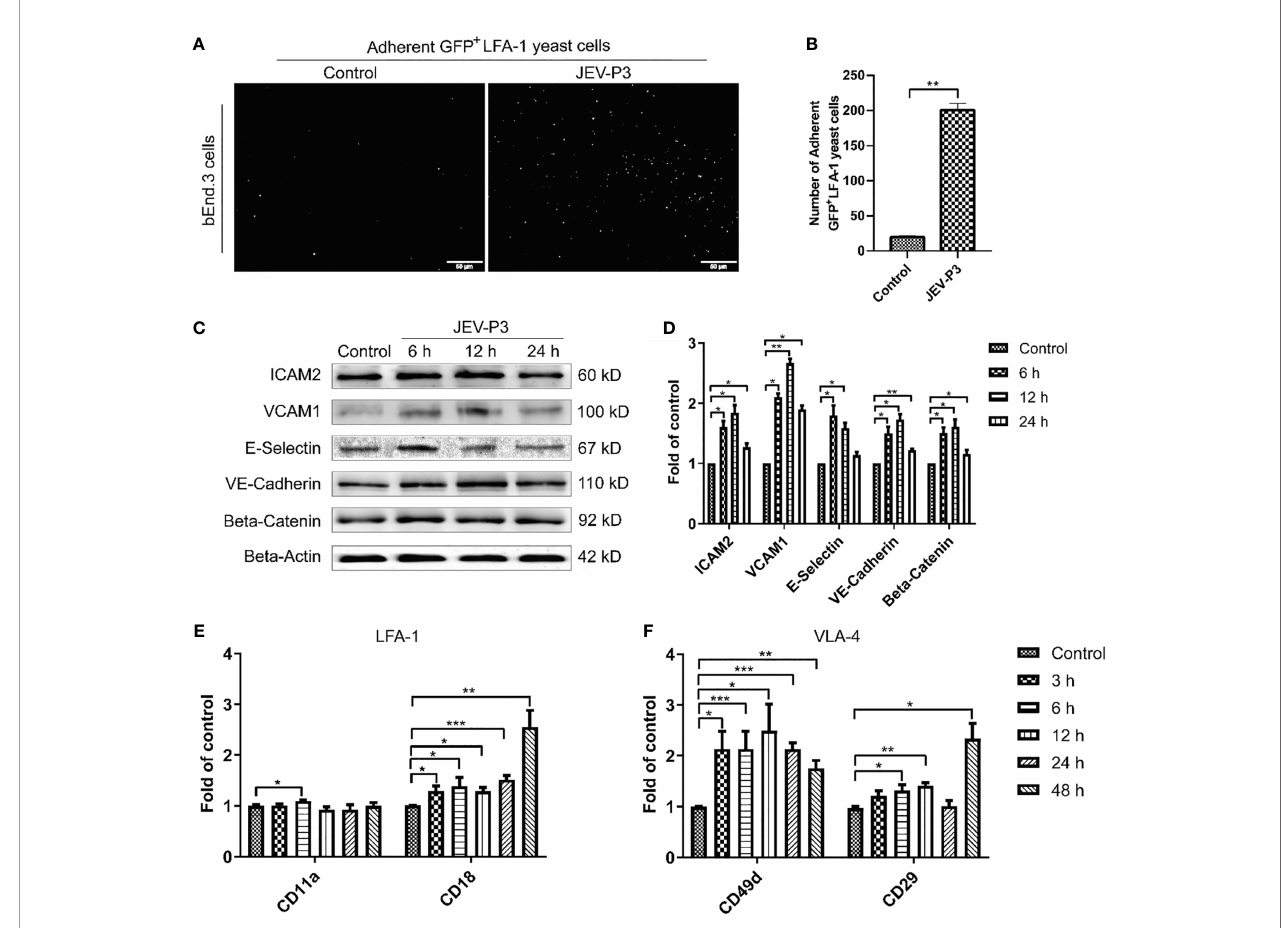
FIGURE 2 | JEV infection upregulated adhesion molecules expression in bEnd.3 cells, and rHMGB1 increased the expression of integrin ligands in splenocytes. (A) ICAM-1 expression level was detected in the JEV-infected bEnd.3 cells at 6 h. Representative images showing the binding of highly expressed GFP + LFA-1 yeast cells. (B) Statistical analysis of fl uorescence was performed, and the result represents the expression levels of ICAM-1 in bEnd.3 cells. (C) Detection of ICAM-2, VCAM-1, E-selectin (CD62E), VE-cadherin, and beta-catenin expression levels in JEV-infected bEnd.3 cells were determined by Western blotting. Protein samples were collected at 0 h (Control), 6 h, 12 h, and 24 h. (D) The protein expressions reported in panel (C) were normalized to that of beta-actin and quantitatively analyzed as the fold change relative to the control. The expression levels of LFA-1 (CD11a and CD18) (E) and VLA-4 (CD49d and CD29) (F) in rHMGB1-treated (100 ng/ml) mouse splenocytes, determined by real-time PCR at 0 h (Control), 3 h, 6 h, 12 h, 24 h, 48 h. Untreated cells were served as control. The scale bar for (A) is 50 m m. The experiments were repeated at least three times. The data are expressed as the means ± SEM. * p < 0.05, ** p < 0.01, and *** p <